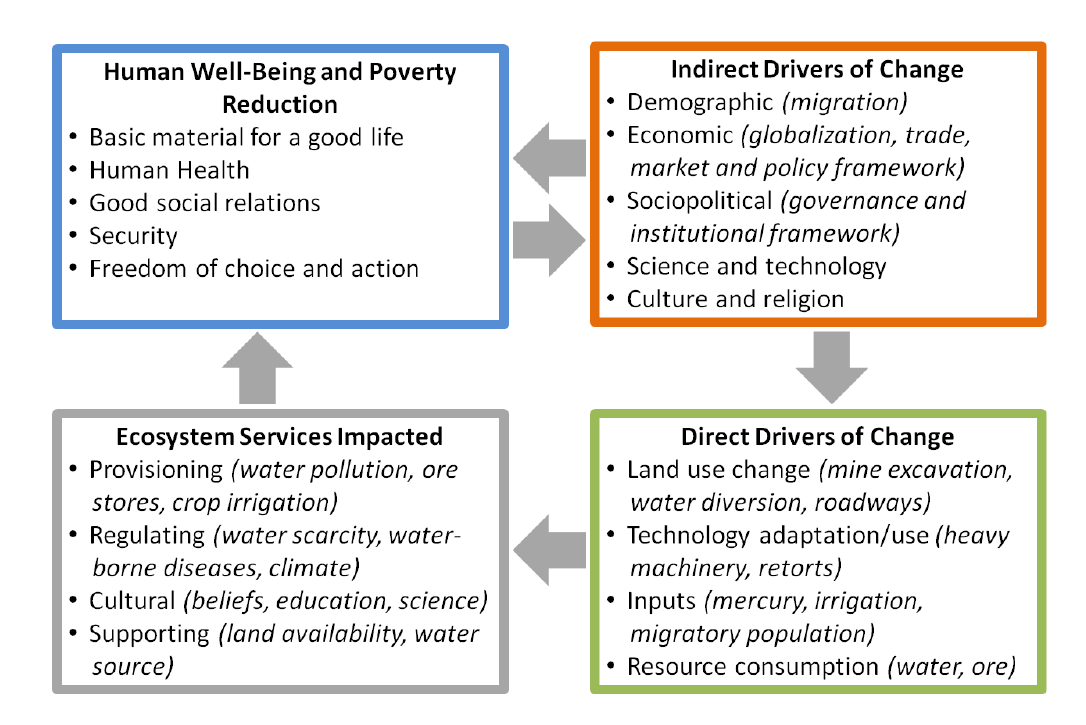
Figure 1. Framework linking key drivers and impacted natural systems. Principal domains of inquiry are highlighted. Framework is adapted from the Millennium Ecosystem Assessment